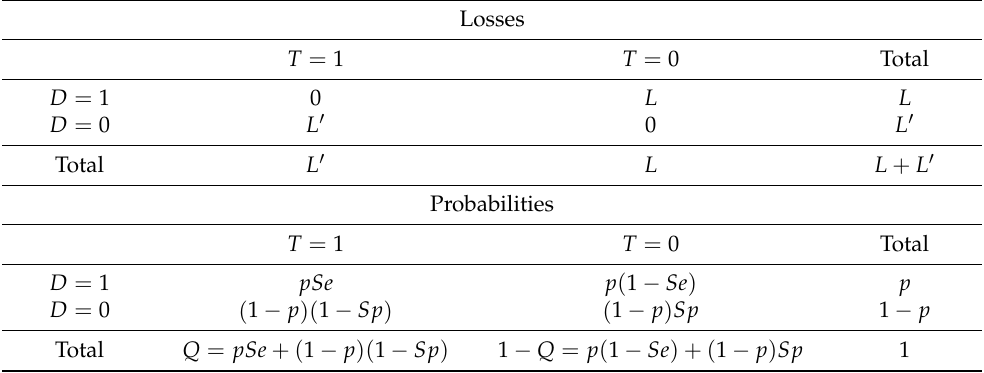
Table 1. Losses and observed frequencies associated with the assessment of a BDT in relation to a